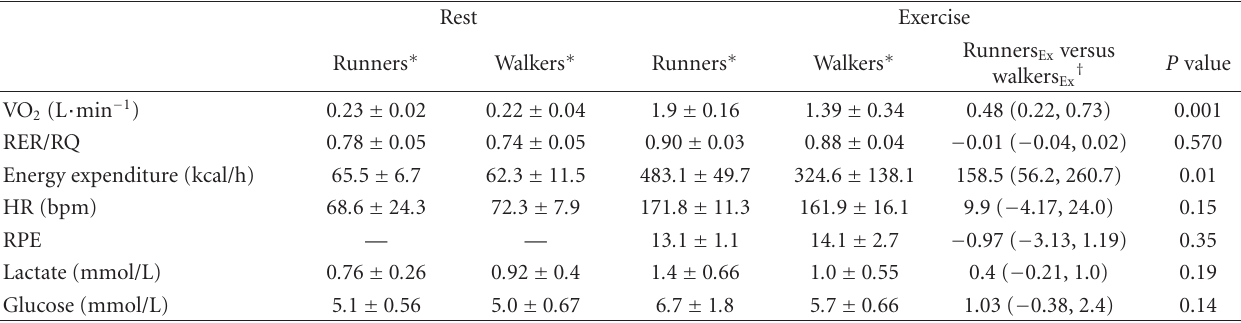
Figure 2: Average hematocrit for runners and walkers during exercise (solid grey) and rest (dashed black). “Pre” represents the time point just before exercise or rest. Vertical bars display the standard error of the mean hematocrit concentration at that time point. Table 2: Oxygen uptake, energy expenditure, and heart rate of 9 female runners and 10 female walkers during 60 min of exercise and 60 min of bed rest. VO 2 : volume of oxygen uptake; RER: respiratory exchange ration; RQ: respiratory quotient; HR: heart rate; RPE: rating of perceived